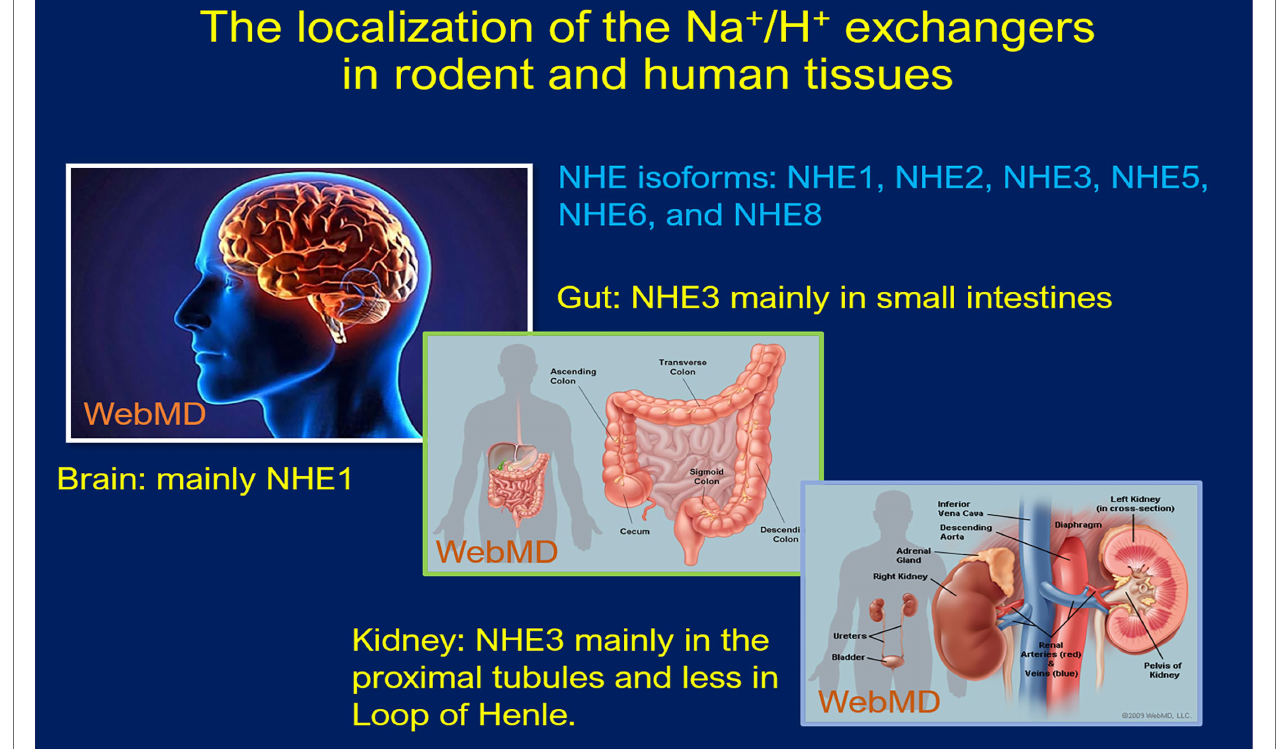
FIGURE 1 | Schematic localization of the Na + /H + exchanger expression in human and rodent tissues. NHE1 and NHE2 are expressed in almost every tissue type, including intestinal, kidney, testicular, gastric parietal, and skeletal muscle cells etc. NHE4 expression occurs in the GI tract, whereas NHE5 is most prominently expressed in the brain on glioma cells. NHE6–9 are specific in their intracellular localization found in endosomes, while NHE7 is localized to the trans-Golgi network along with early and recycling endosomes. NHE8 is also an intracellular NHE protein, especially in late endosomes and facilitates alkalinization of the